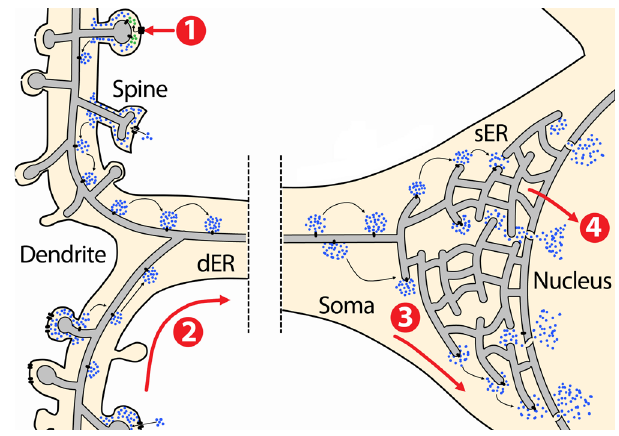
Figure 2. Calcium signal propagation from the synapse to the nucleus. The endoplasmic reticulum (ER) is distributed throughout the cytoplasm from the nuclear envelope to dendritic spines. Excitatory synaptic stimulation through glutamate causes membrane depolarisation and entry of Ca 2+ (blue dots) from the extracellular space through NMDARs (1). Moreover, glutamate also activates mGluRs coupled to PLC thereby stimulating IP production 3 (green dots). Ca 2+ and IP stimulate receptors present at the ER 3 membrane that open and release more Ca 2+ from the ER lumen, establishing a Ca 2+ -induced Ca 2+ -release wave (2) that propagates from dendrites towards the soma. In the soma, Ca 2+ release from the ER activates cytoplasmic Ca 2+ -dependent signalling cascades that convey the signal to the nucleus (3). Moreover, Ca 2+ can be released to the nucleus from the ER, where it activates nuclear transcription regulators